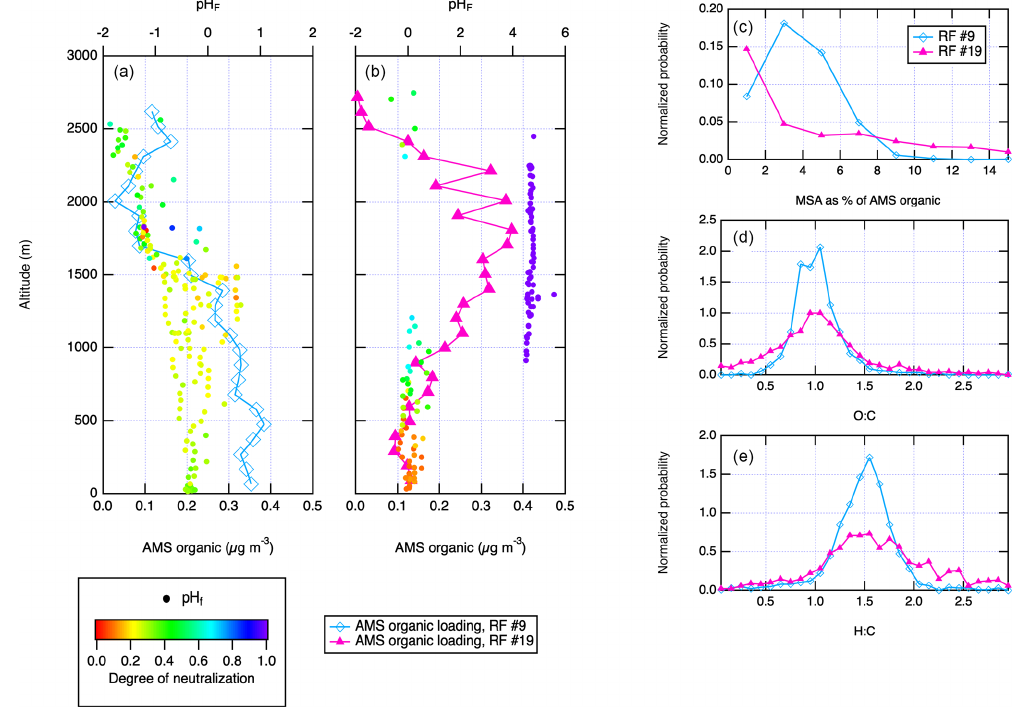
Figure 6. Vertical profiles of AMS organic loading for two research flights representative of different (local vs. remote) transport conditions, overlaid with the calculated pH F during the vertical profile, (a) RF no. 9 and (b) no. 19. (c) Percentage of total AMS organic signal accounted for by MSA during RF no. 9 and no. 19, (d) AMS O : C ratios during RF no. 9 and no. 19, and (e) AMS H : C ratios during RF no. 9 and no. 19. Panels (a) and (b) show only the vertical profiles, while panels (c) – (e) are for the entire